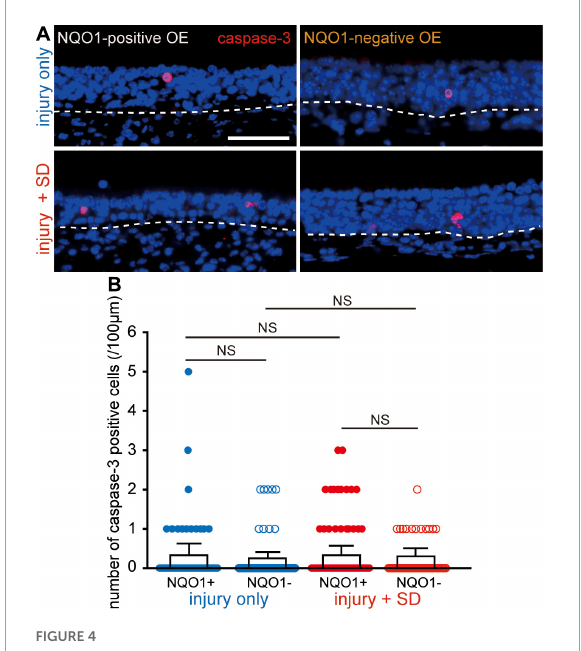
FIGURE4 Neither injury only nor injury combined with sleep deprivation (SD) induces apoptosis. (A) Coronal sections stained with anti-caspase-3 antibody in the NQO1-positive (left), and –negative OE (right) in mice with injury only (upper, injury only) and mice with injury combined with SD (lower, injury + SD). The dashed line represents the basement membrane of the olfactory epithelium (OE). Scale, 50 µ m. (B) Counts of cleaved caspase-3-positive cells in the NQO1-positive and –negative OE, in injury only and injury + SD mice. There was no significant change in the number of caspase-3-positive cells seen in the NQO1-positive OE in mice with injury combined with SD compared with that in mice with injury only. NS, not significant; Steel–Dwass